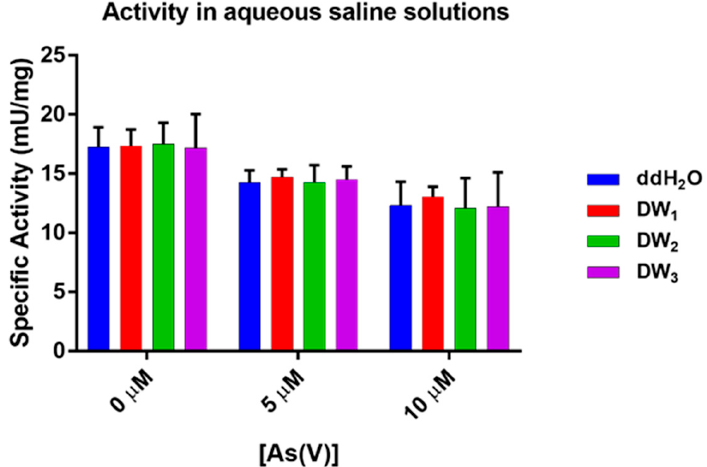
Figure 4. Tt ArsC phosphatase activity performed in ddH 2 O, three drinkable waters (DW), and in the presence of As(V) 5 and 10 μ m.